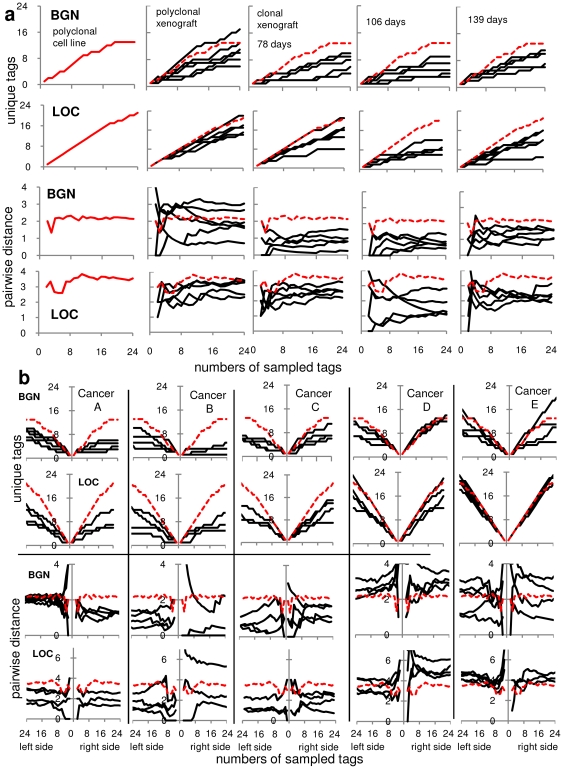
Deeper sampling.
A. More unique epiallele patterns are observed within polyclonal cultures and the small xenograft fragments when sampling is increased to 24 tags. PWD values are relatively stable after 8 sampled tags (for reference, the dotted red lines are the polyclonal cell line values). B. Deeper sampling of glands from five human CRCs. The three cancers on the left are relatively younger cancers with diversity similar to the clonal xenografts. The two cancers on the right are relatively older cancers with diversity similar to the polyclonal cell line or xenografts. Consistent with a single clonal expansion, diversity is similar between right and left parts of the same CRC.